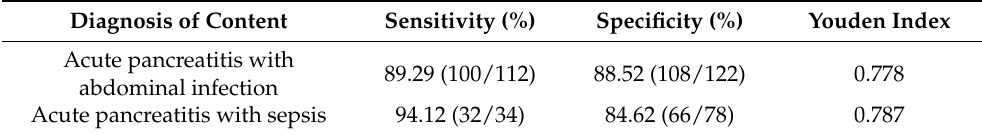
Table 6. CD64 index and PCT combined diagnostic